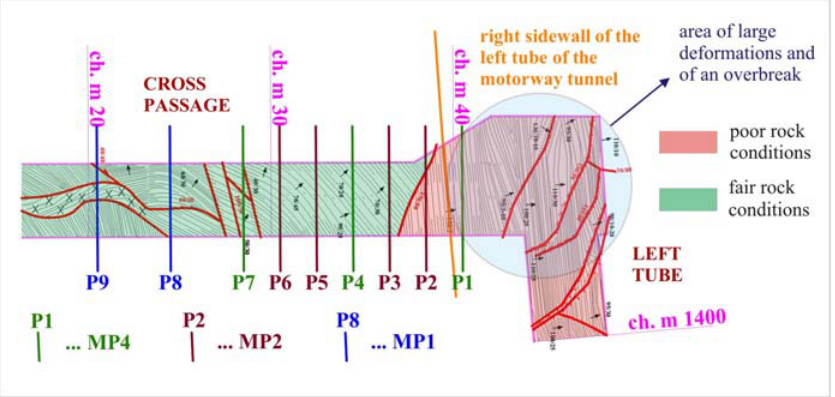
Figure 7. Disposition of the measuring cross sections and control station positions in cross passage of the exploratory tunnel with lined geological